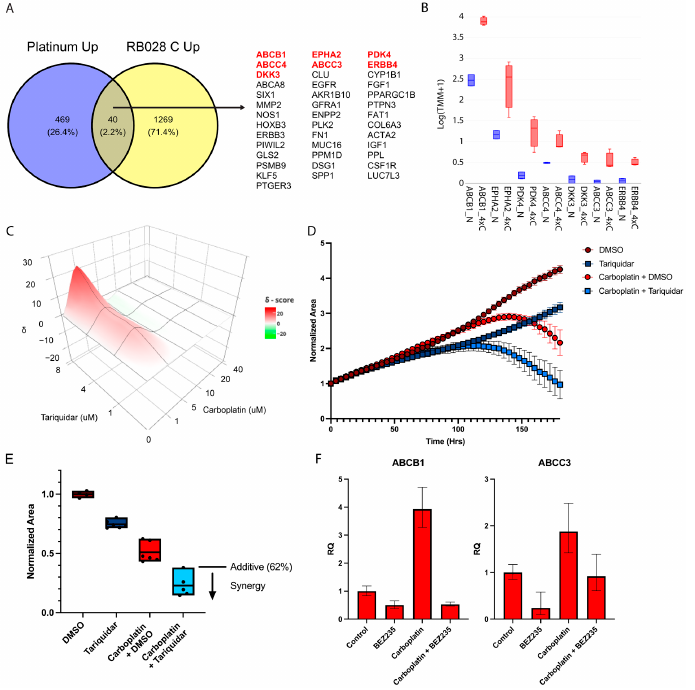
Figure 4. Carboplatin resistance potentiated by ABCB1 inhibitor tariquidar. ( A ) Venn diagram of genes upregulated in a platinum resistance database (Platinum Up) and genes upregulated in RB028 4xC compared to RB028 Naive cells (RB028 C Up). Genes analyzed further in panel B are indicated in red. ( B ) RNA-seq data of select genes upregulated by carboplatin in RB028 4xC (red) and RB028 Naive (blue) cells. ( C ) Representative 3D synergy plot of RB028 4xC using Bliss scores. ( D ) Normalized viability of RB028 4xC cells monitored over 8 days after challenge with carboplatin (1 μ M) along with tariquidar (4 μ M). ( E ) Normalized viability of RB028 4xC cells at the endpoint from panel C for the indicated treatment groups (Bliss score = 62.1%, observed inhibition = 77.2%, and excess over Bliss score = 15.1%). ( F ) qPCR of ABCB1 and ABCC3 with BEZ-235 (1 μ M) and carboplatin (1 μ M) on Day 3. Error bars represent confidence intervals set to 95th percentile.